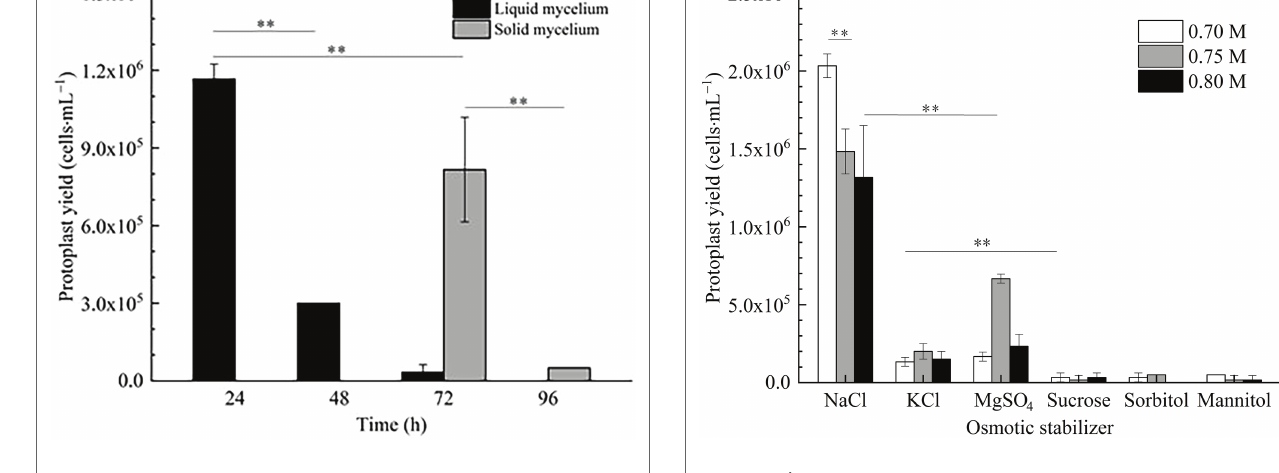
FIGURE 1 | Effect of fungal age and mycelium status on strain D-1 protoplast preparation ( ** p <